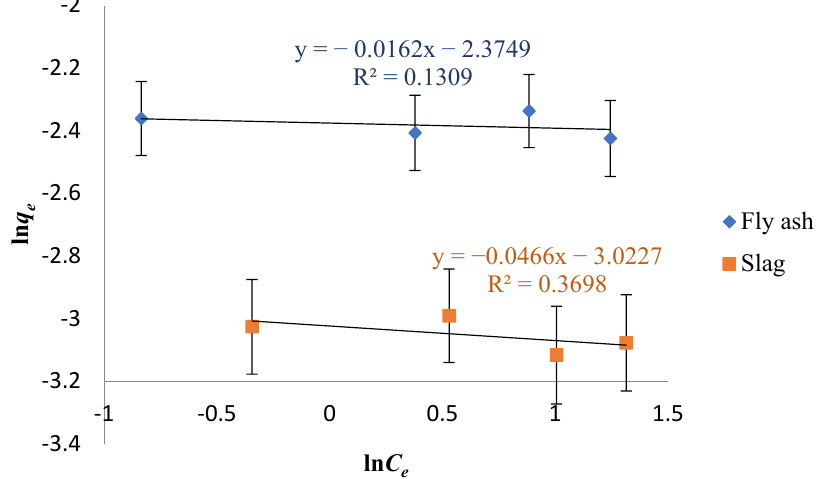
Figure 9. The Cs adsorption of the Freundlich isotherm on the fly ash-based geomaterials and slag-based geomaterials. Table 4. Coefficient of Langmuir and Freundlich isotherms for Cs.